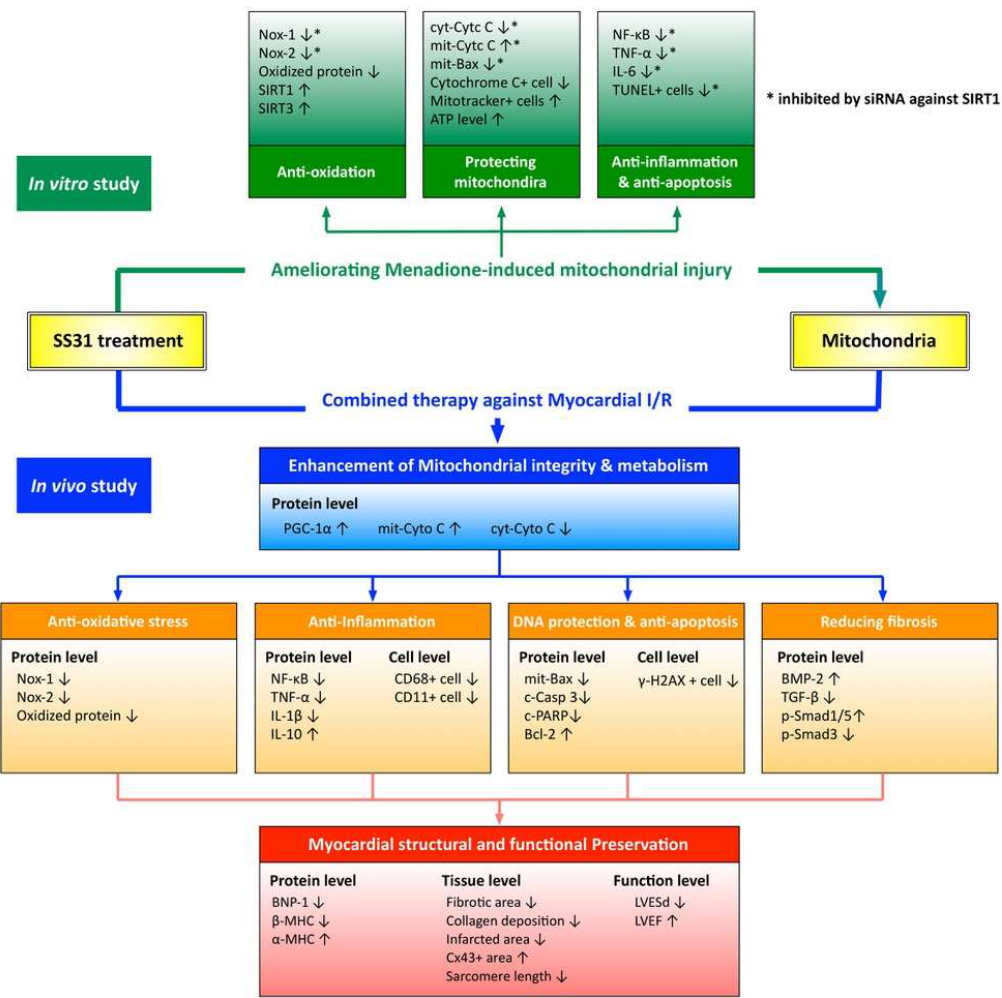
Figure 14. Proposed mechanisms underlying the positive therapeutic effects of combined SS31 and mitochondria preserved heart function in a setting of ischemia-reperfusion myocardial injury. The protective effects of combined SS31 and mitochondria on myocardium and heart function are completed by inhibiting inflammation, oxidative stress, cellular apoptosis, DNA/mitochondrial damage, and myocardial fibrosis.